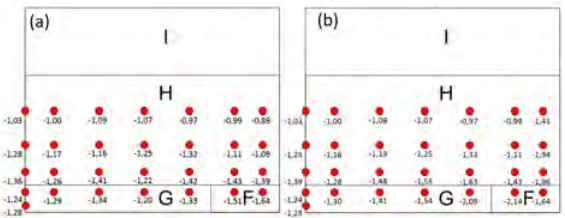
pe values of the flow